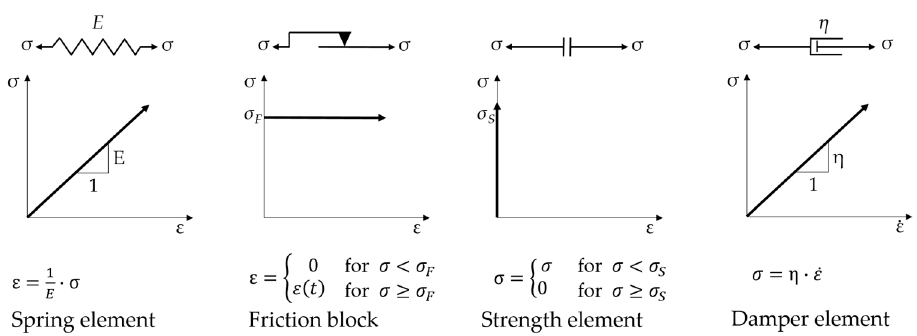
Figure 5. Basic rheological elements and their idealised material behaviours.